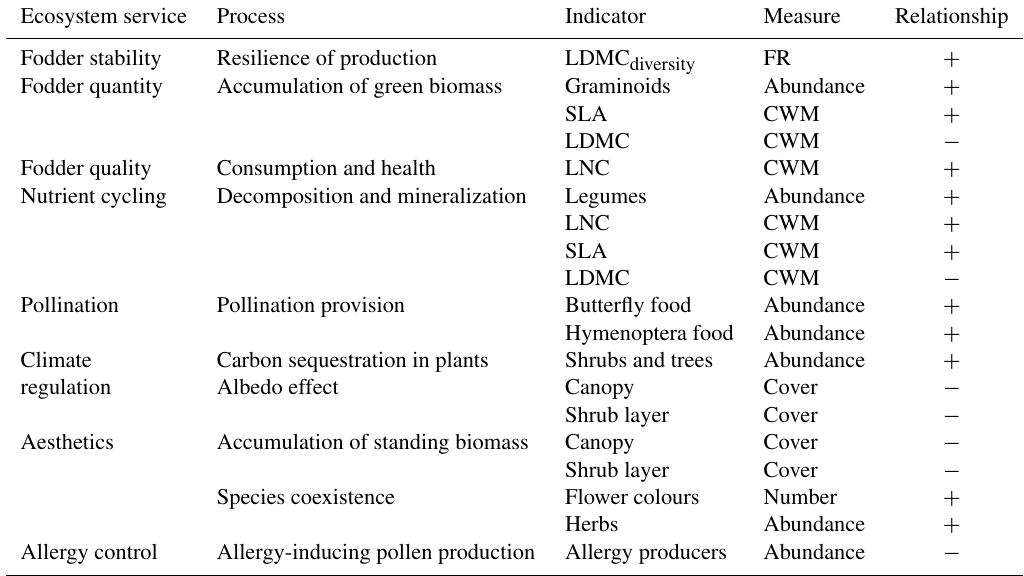
Table 1. Ecosystem services (ES) provided by semi-natural grasslands. Vegetation characteristics (indicators) and measures used to indicate the ESs, the processes they affect, and the nature of the relationship (positive ( + ) or negative ( − )) between the